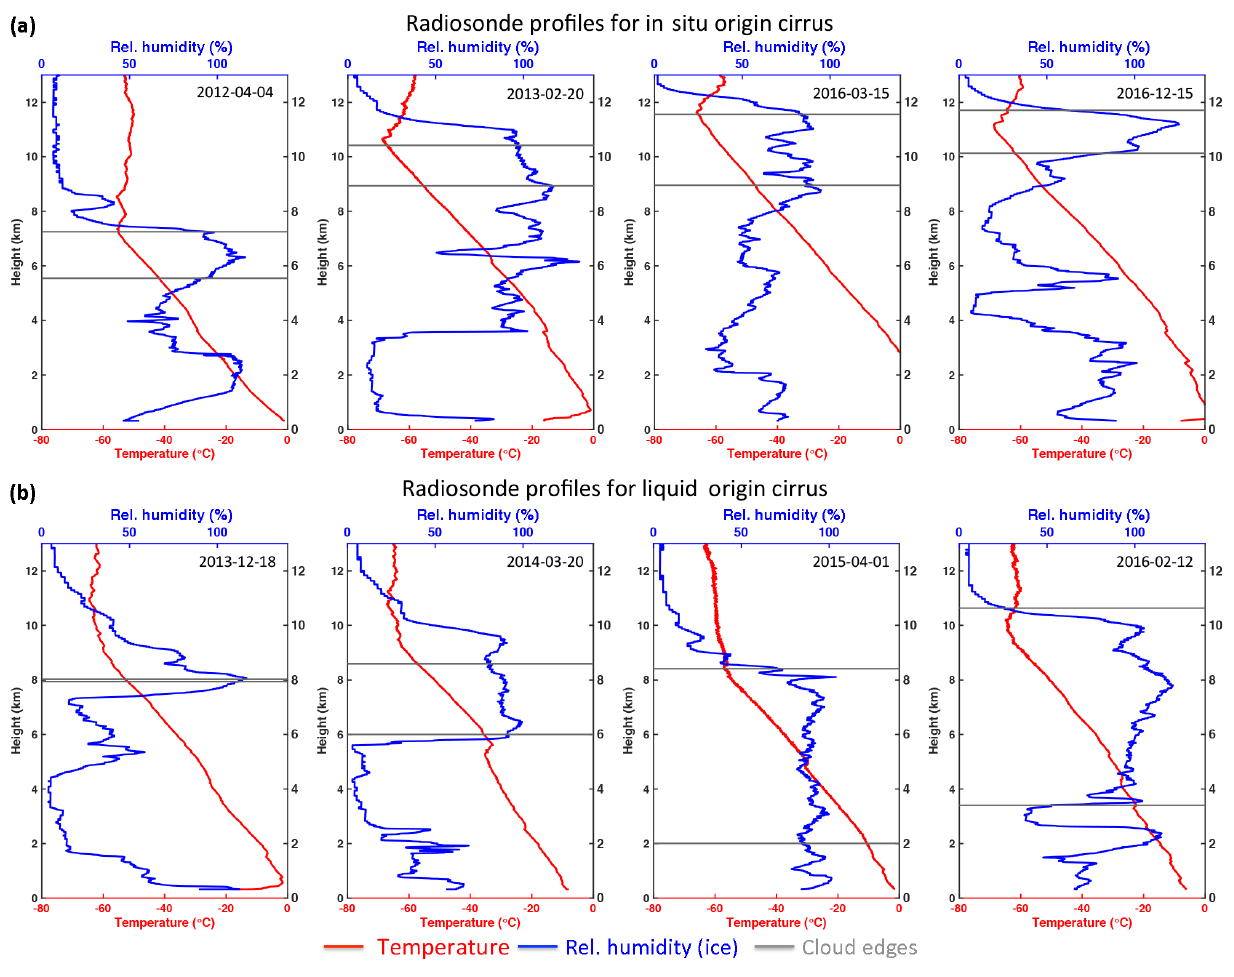
Figure 5. Temperature (red) and relative humidity profiles (blue) with respect to ice for the eight measurement days ( a : in situ origin, b : liquid origin). The clouds upper and lower edges are marked by horizontal